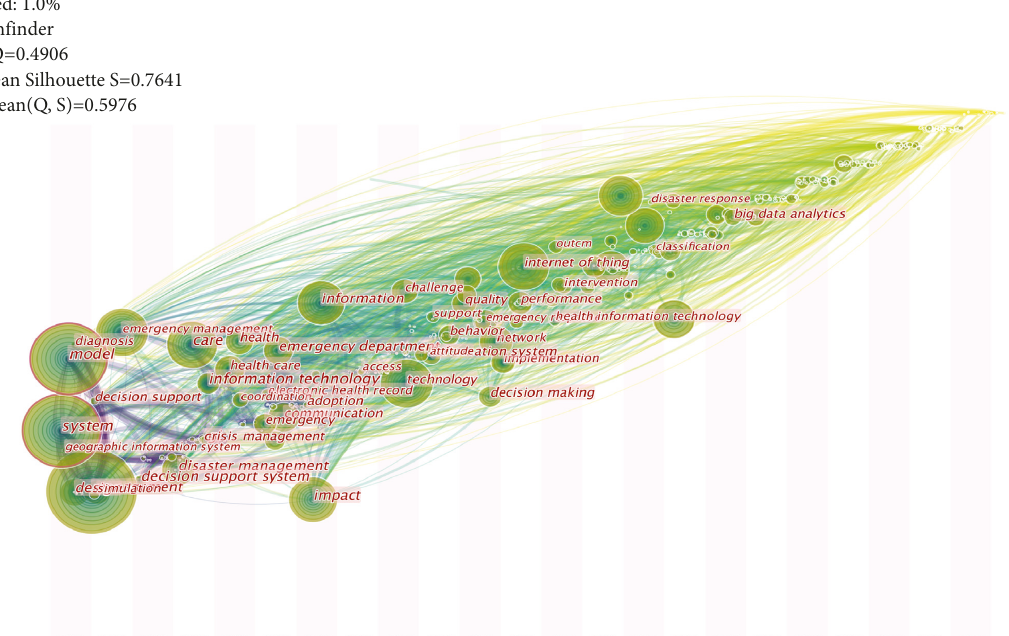
Figure 12: Time zone map of keywords of international DEM